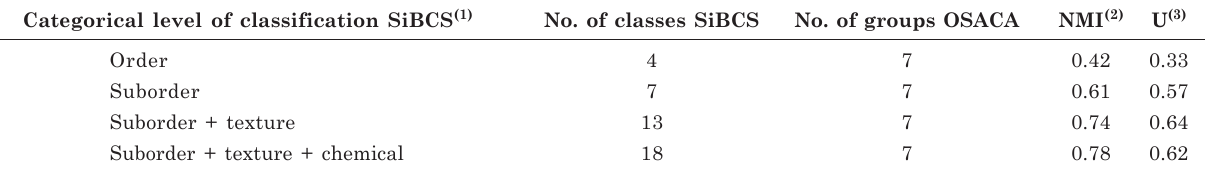
(1) According to Embrapa ( 2013); (2) Normalized Mutual Information; (3) Uncertainty